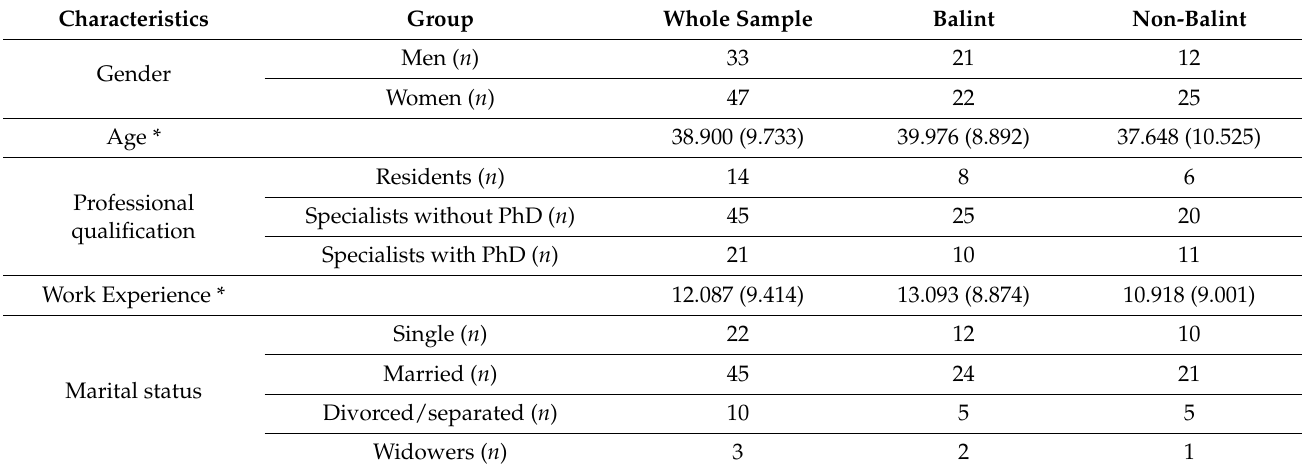
Table 1. Descriptive data of all